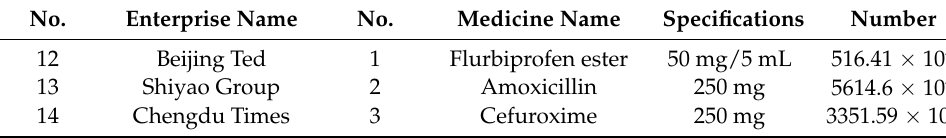
Table 1. Companies and medicines.